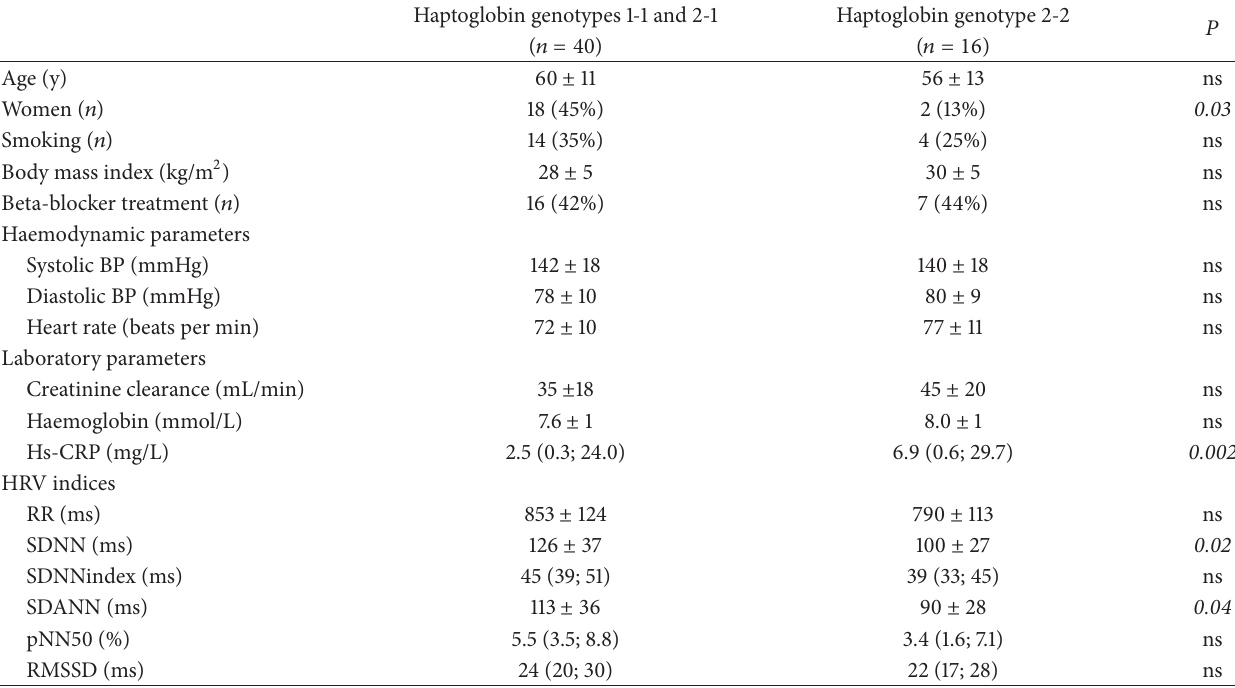
Table 1: Clinical characteristics of patients with haptoglobin genotype 2-2 compared to patients with haptoglobin genotypes 1-1 and 2-1.